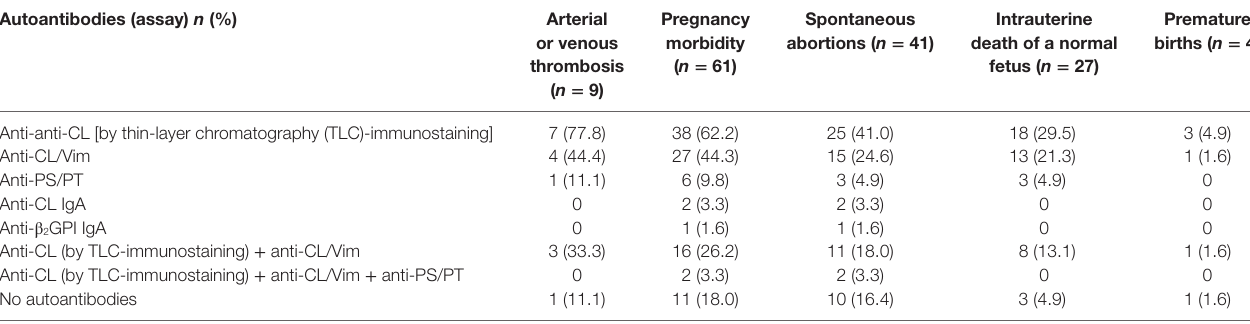
Table 2 | Autoantibody prevalence according to the clinical manifestations. autoantibodies (assay) n (%) arterial